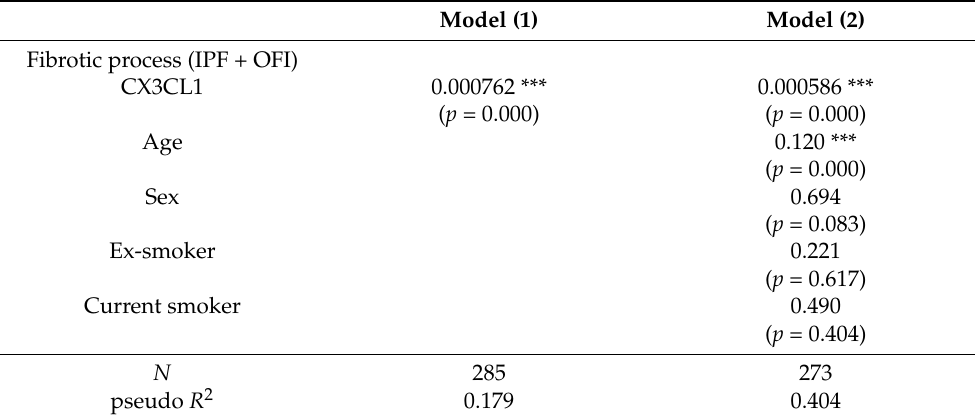
Table 2. Logit models of CX3CL1 effect on fibrotic process.